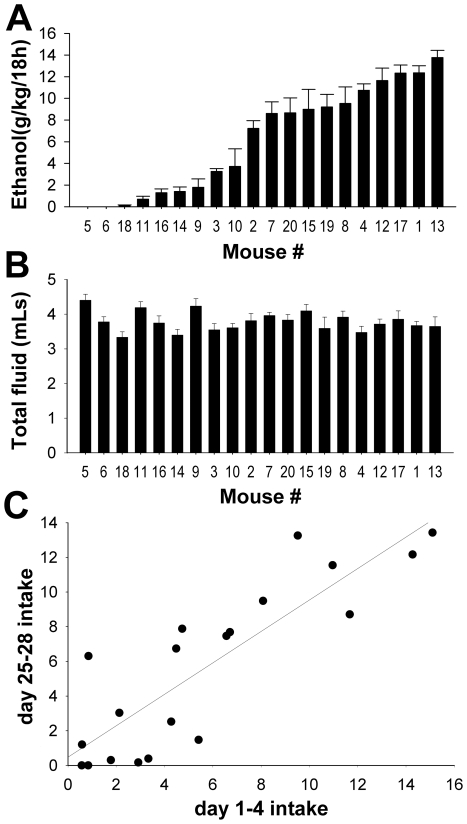
Ethanol drinking in individual C57BL/6NCrl mice.
A. Ethanol intake expressed in grams per kilogram body weight over 18 hours of ethanol access. Mice show a robust, but persistent variation in ethanol drinking. B. Total liquid consumed (ml ethanol + ml water) in 18 h/day. C. Scattergram of ethanol drinking on days 1–4 versus days 17–28, correlation R = 0.738, p<0.0002.